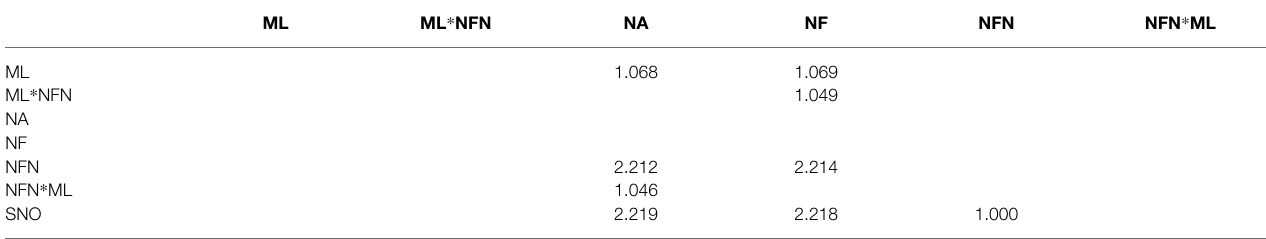
TABLE 5 | Collinearity statistics (inner-VIF values).